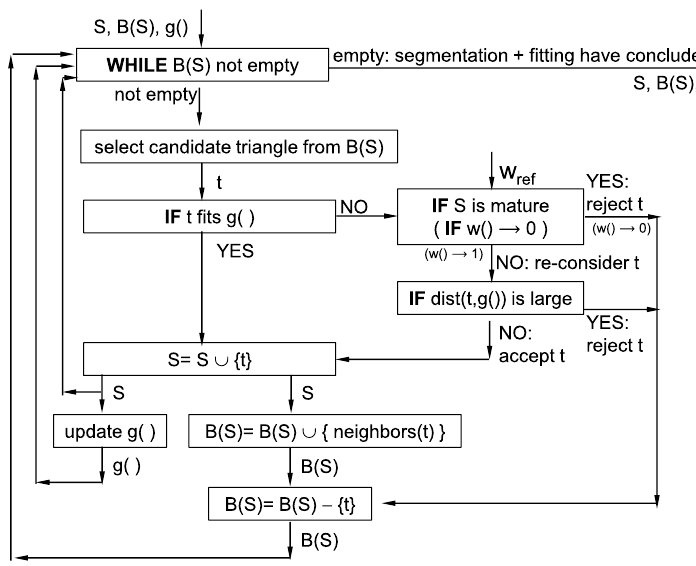
Figure 13. Algorithm for simultaneous fitting of g () and extraction of g () support subset S